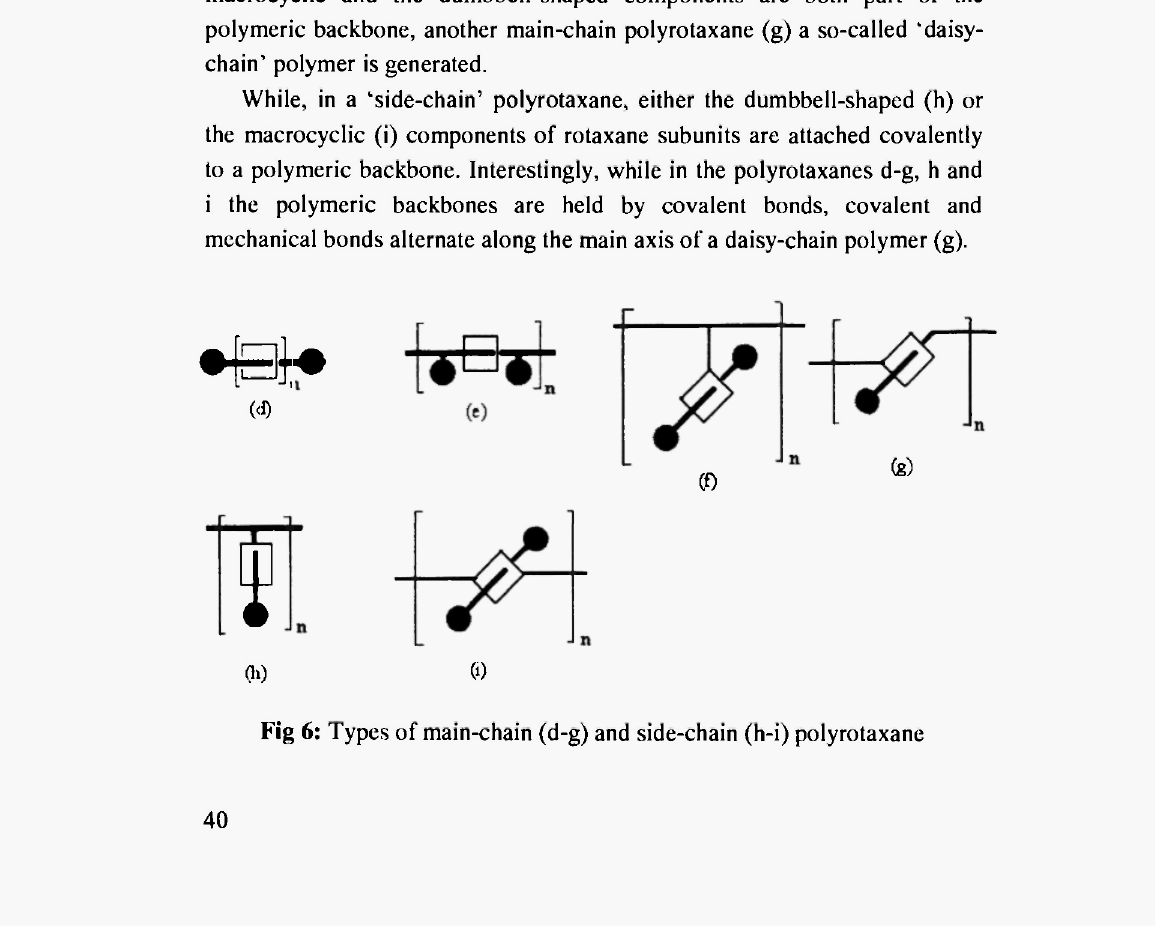
Fig. 5: A schematic representation of polyrotaxanes: (a) linear, (b) comb- like